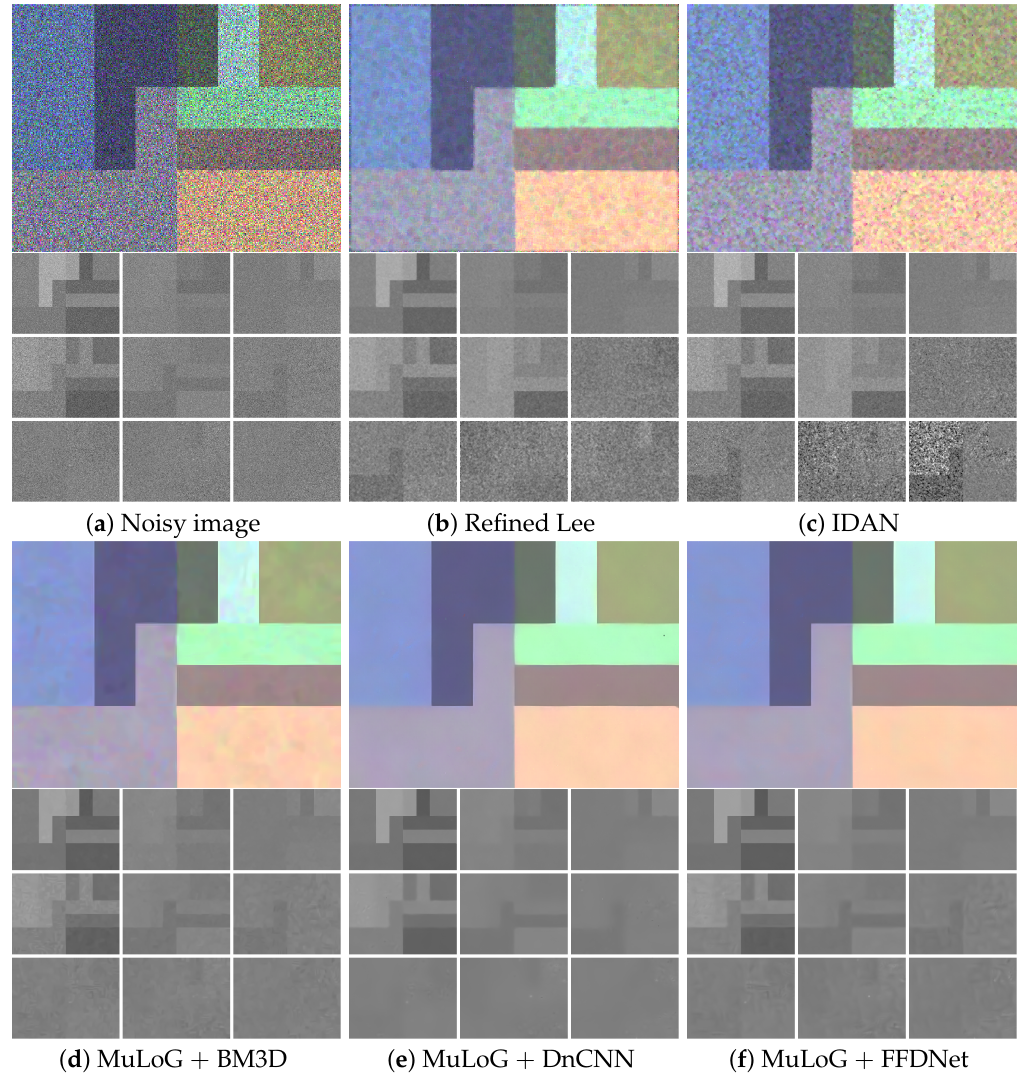
Figure 13. The denoising results for simulated PolSAR image with L = 1: ( a – f ) Noisy image, Refined Lee, IDAN, MuLoG + BM3D, MuLoG + DnCNN, and MuLoG + FFDNet, respectively. For each image, the nine log channels x 1 , x 2 , . . . , x 9 are displayed on